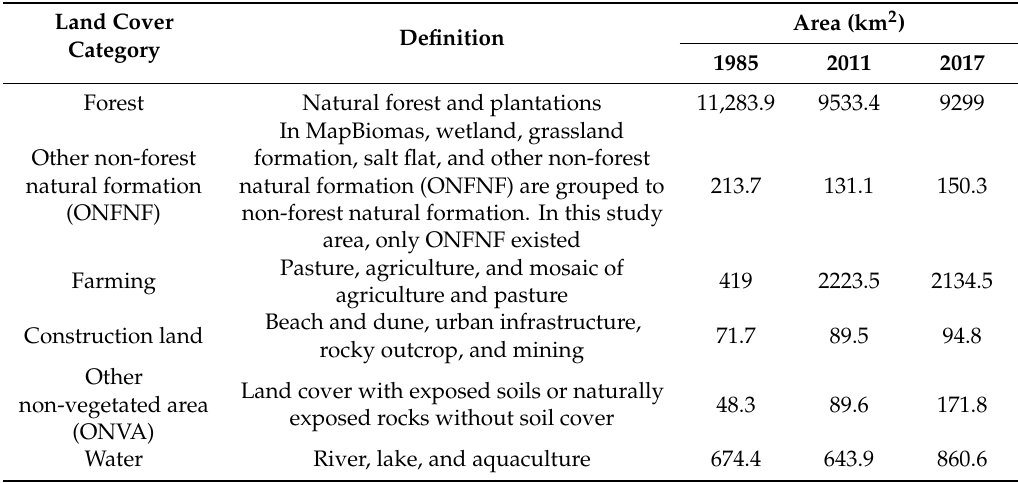
Table 2. Definitions of land use and land cover categories and a summary of statistical area for each category in this study area in 1985, 2011, and